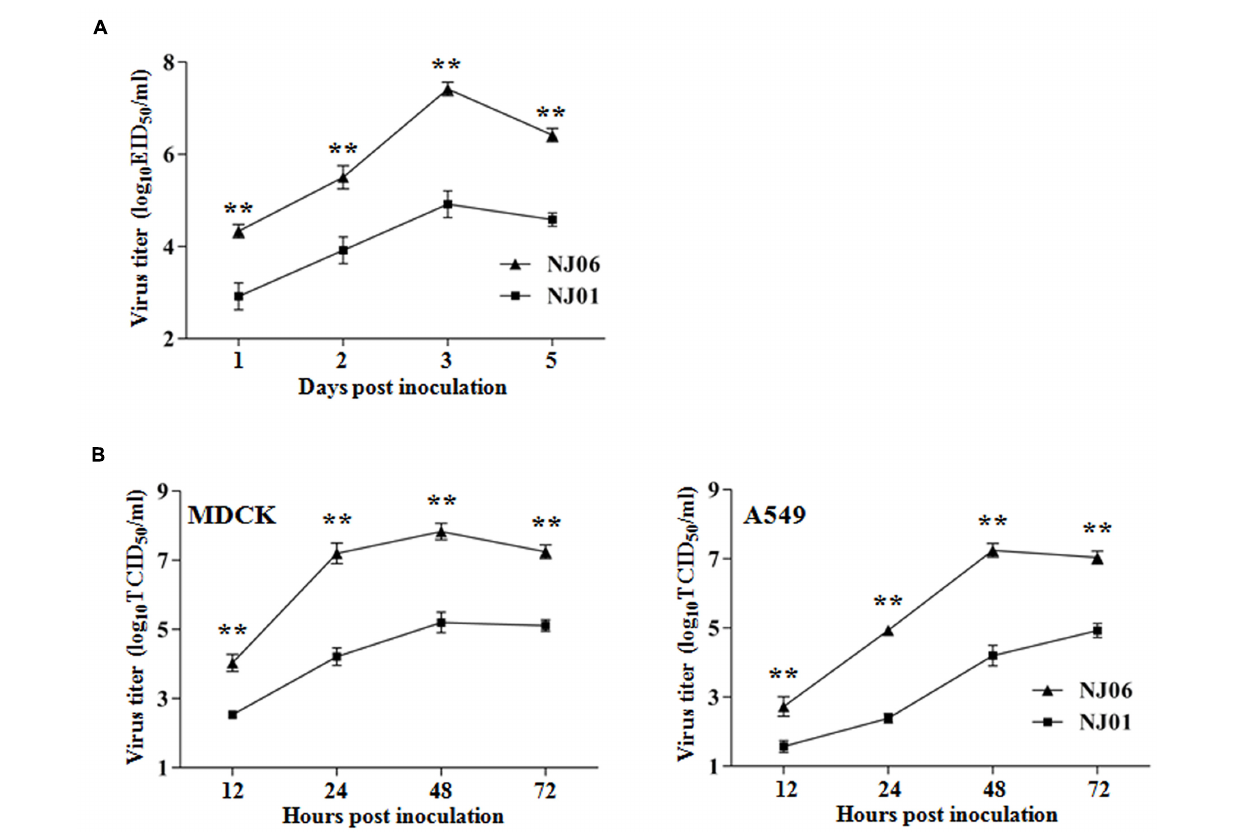
FIGURE 2 | Replication kinetics of NJ06 and NJ01viruses in vivo and in vitro . (A) Groups of three BALB/c mice were inoculated intranasally with 10 5 EID 50 of NJ06 or NJ01 viruses, and lungs were collected at for virus titration in eggs on the indicated days. (B) Madin–Darby canine kidney (MDCK) or A549 cells were infected with NJ06 or NJ01 viruses at a multiplicity of infection of 0.01, and virus yields were determined in MDCK cells at appropriate time points. Data represent the means of the results determined for three independent experiments ± standard deviations. ∗∗ P < 0.01 compared with the value for the NJ01